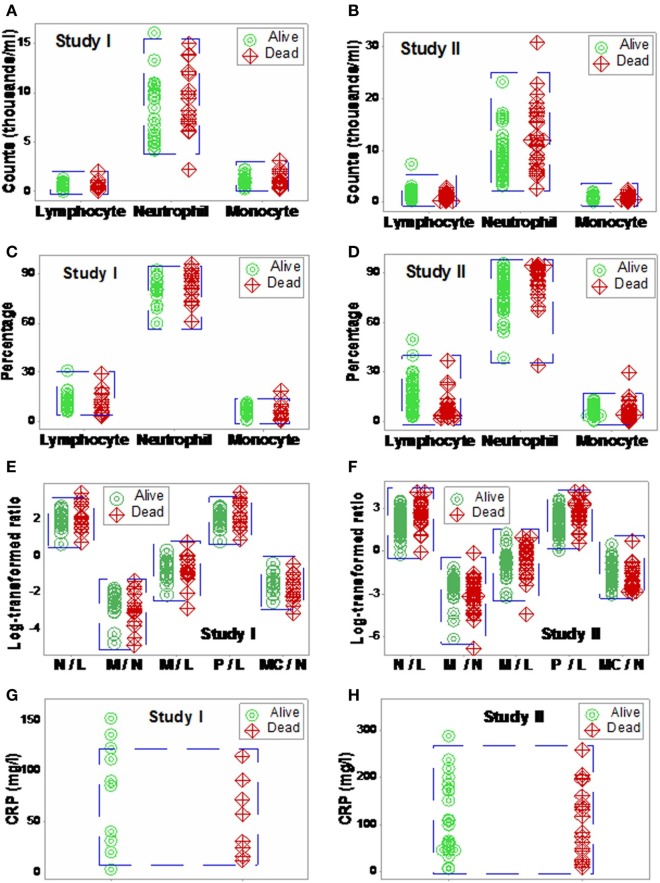
Non-partitioning-based (non-combinatorial) analysis of leukocyte and biomarker data. The outcomes reported within 30 days after SIRS+, infected individuals were admitted were not differentiated by input (blood leukocyte) data collected at admission. Both counts (A,B), percentages (C,D), and ratios of leukocyte cell types (E,F) as well as CRP concentrations (G,H) did not distinguish survivors from non-survivors: data overlapping was observed in both studies (blue boxes).